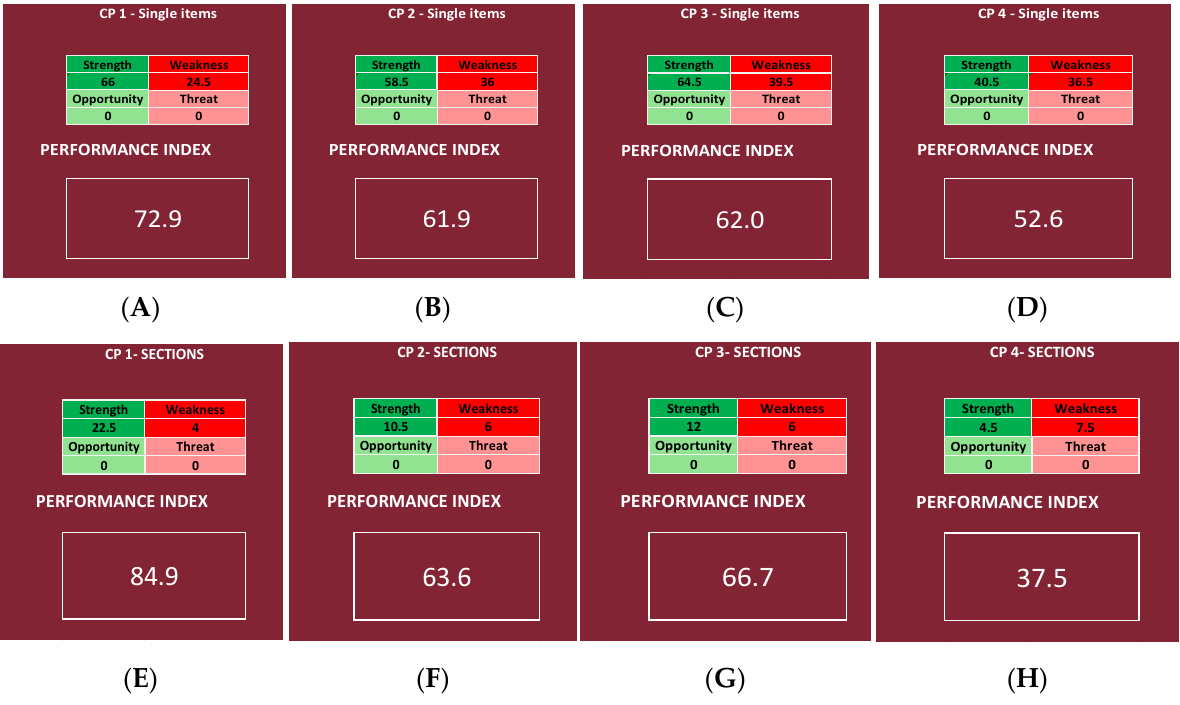
Figure 10. Performance indexes calculated for each CP, using the mean scores of every item of the questionnaire ( A – D ) and using the mean scores of every Questionnaire Section ( E – H ). For CP1, the deeper analysis is shown in ( A ), and the shallower one is in ( E ); for CP2, the deeper analysis is shown in ( B ), and the shallower one is in ( F ); for CP3, the deeper analysis is shown in ( C ), and the shallower one is in ( G ); lastly, for CP4, the deeper analysis is shown in ( D ), and the shallower one is in ( H ).